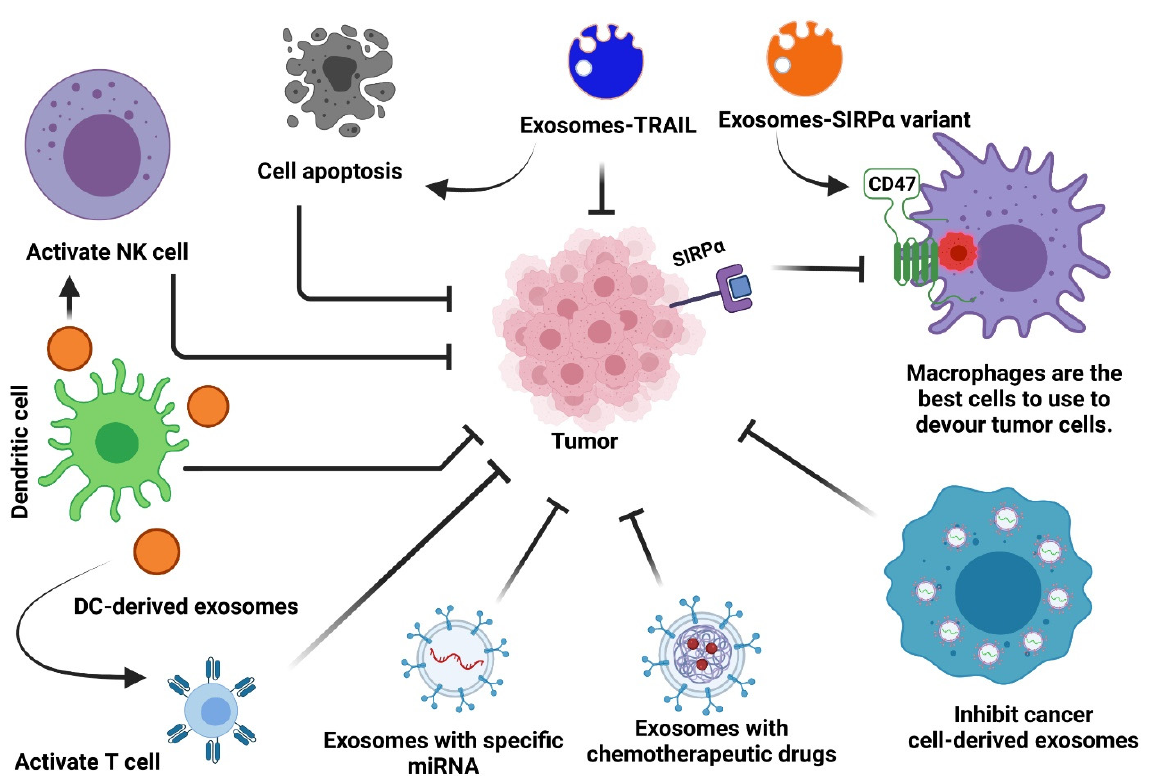
Figure 2. Exosome-based cancer therapies. Cancer treatments based on exosomes may be classified into two broad categories: 1. exosomes from immune cells repress cancer cells; 2. exosomes that serve as gene carriers.